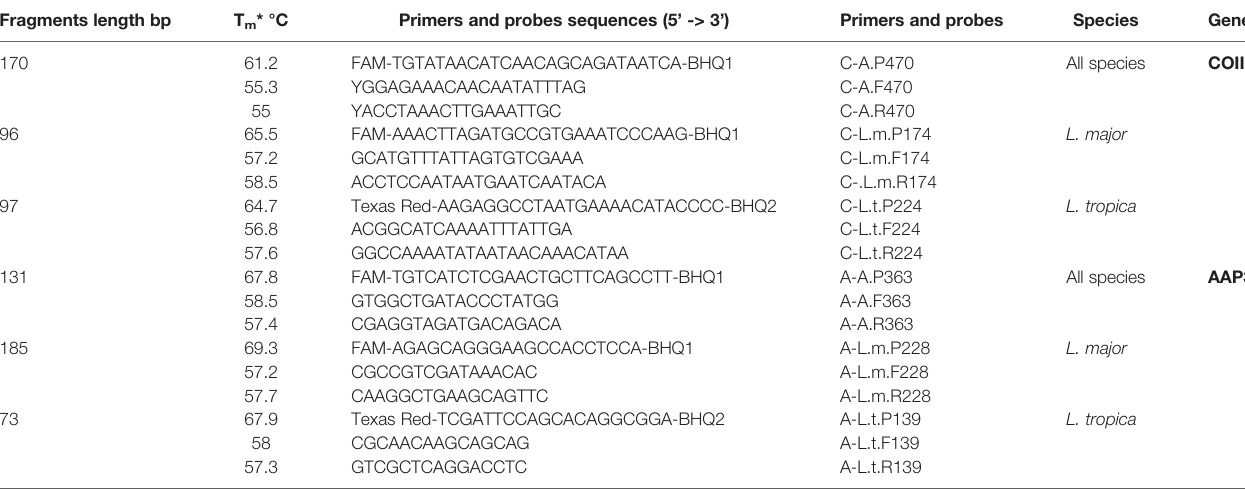
TABLE 2 | Designed primers and probes in TaqMan real-time PCR method for Leishmania species in this study. Fragments length